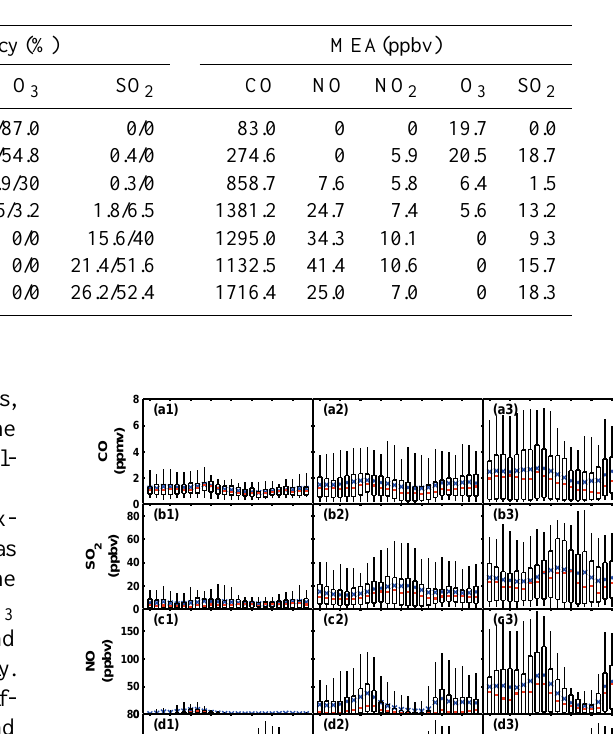
Table 2. Monthly exceedance hour frequency, High Pollution Day (HPD) frequency and Mean Exceeded Amount (MEA) of CO, NO, NO 2 and O 3 (calculation method given in Sect. 2.3).